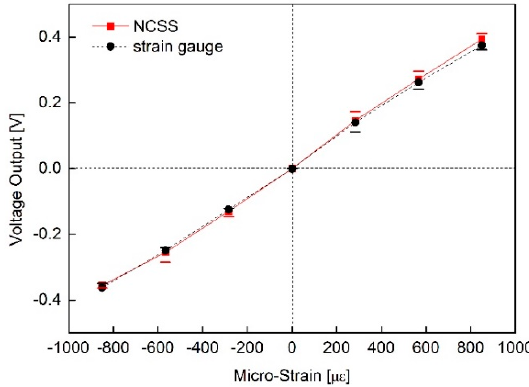
Figure 6. Strain sensing linearity of the MWCNT/epoxy NCSS.